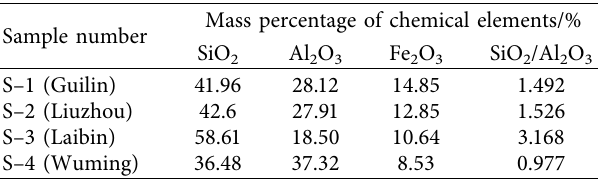
Figure 4: SEM photographs of samples in Wuming. (a) Original sample ( × 8000) (b) Extract sample ( × 8000). (c) Original sample dissolved water ( × 100) (d) Original sample dissolved water ( × 500). Table 3: Analytical results by XRF tests.